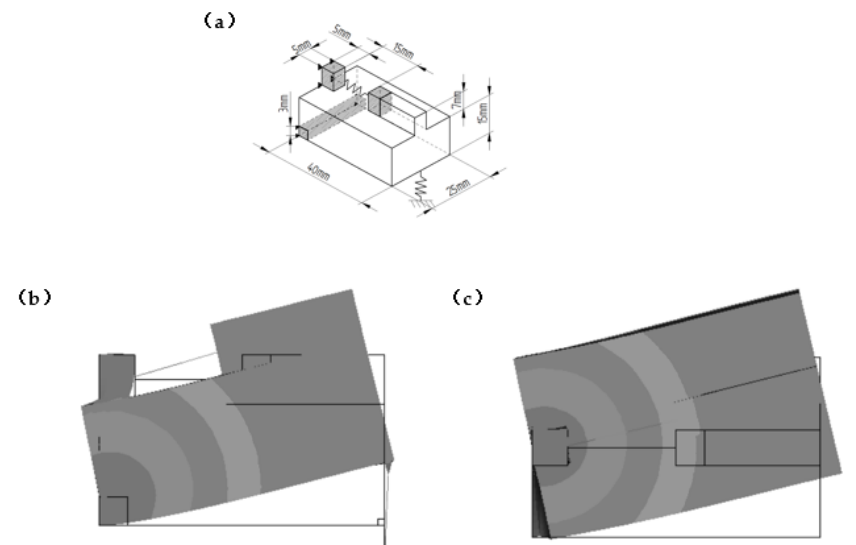
Figure 6. ( a ) Design domain and boundary of the steering mechanism; ( b ) the first eigenmode is a swing modal in vertical direction with eigen-frequency 1912 Hz; ( c ) the second eigenmode is a swing modal in horizontal direction with eigen-frequency 2186 Hz.